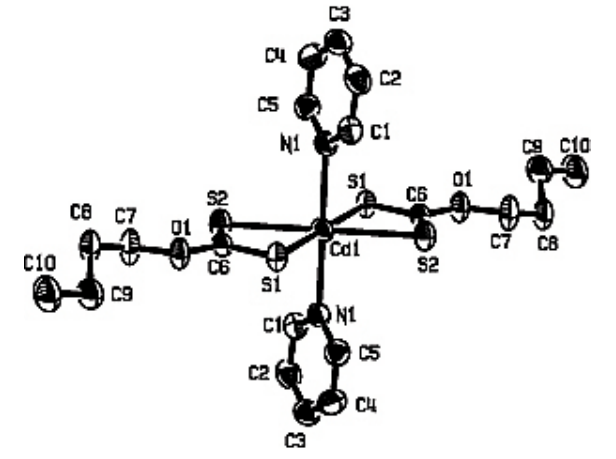
Selected bond lengths (nm) and bond angles ( º